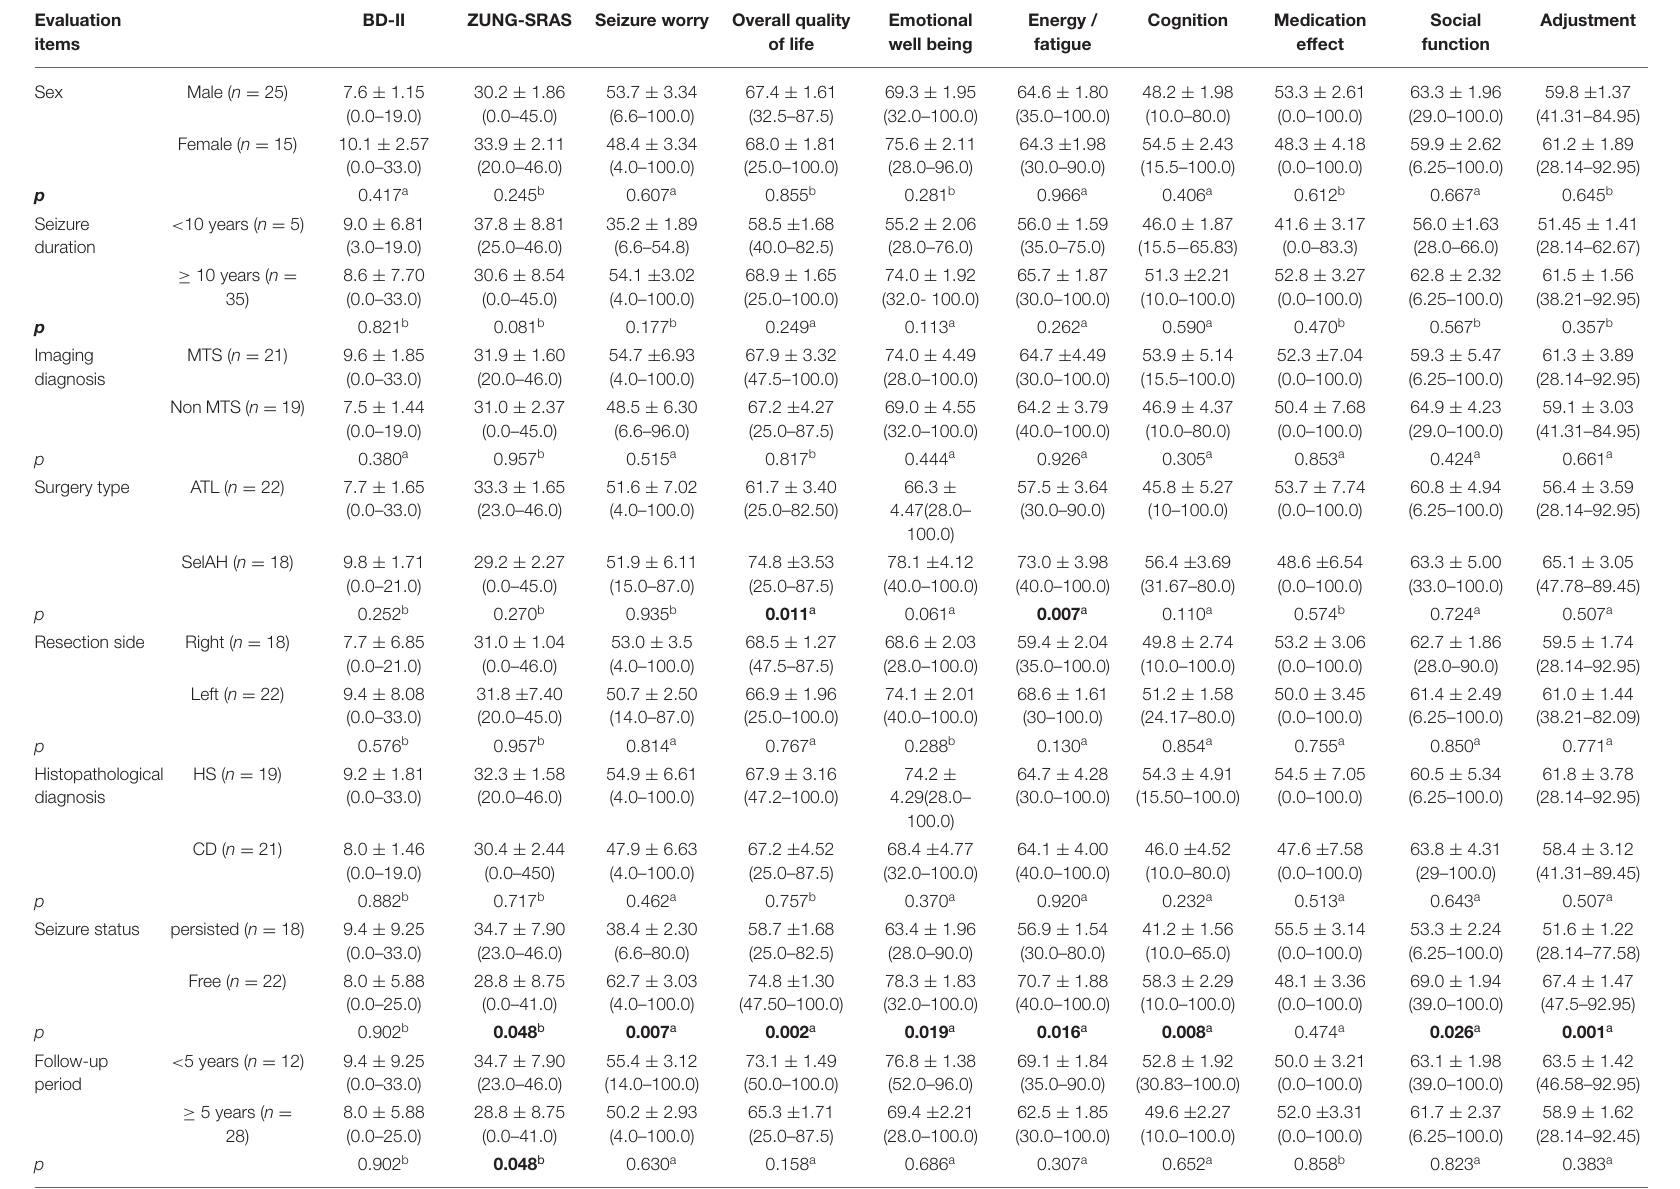
TABLE 2 | Multivariate analysis of BD-II, ZUNG-SRAS, and QOLIE-31 scores based on demographic and clinical variables. Evaluation